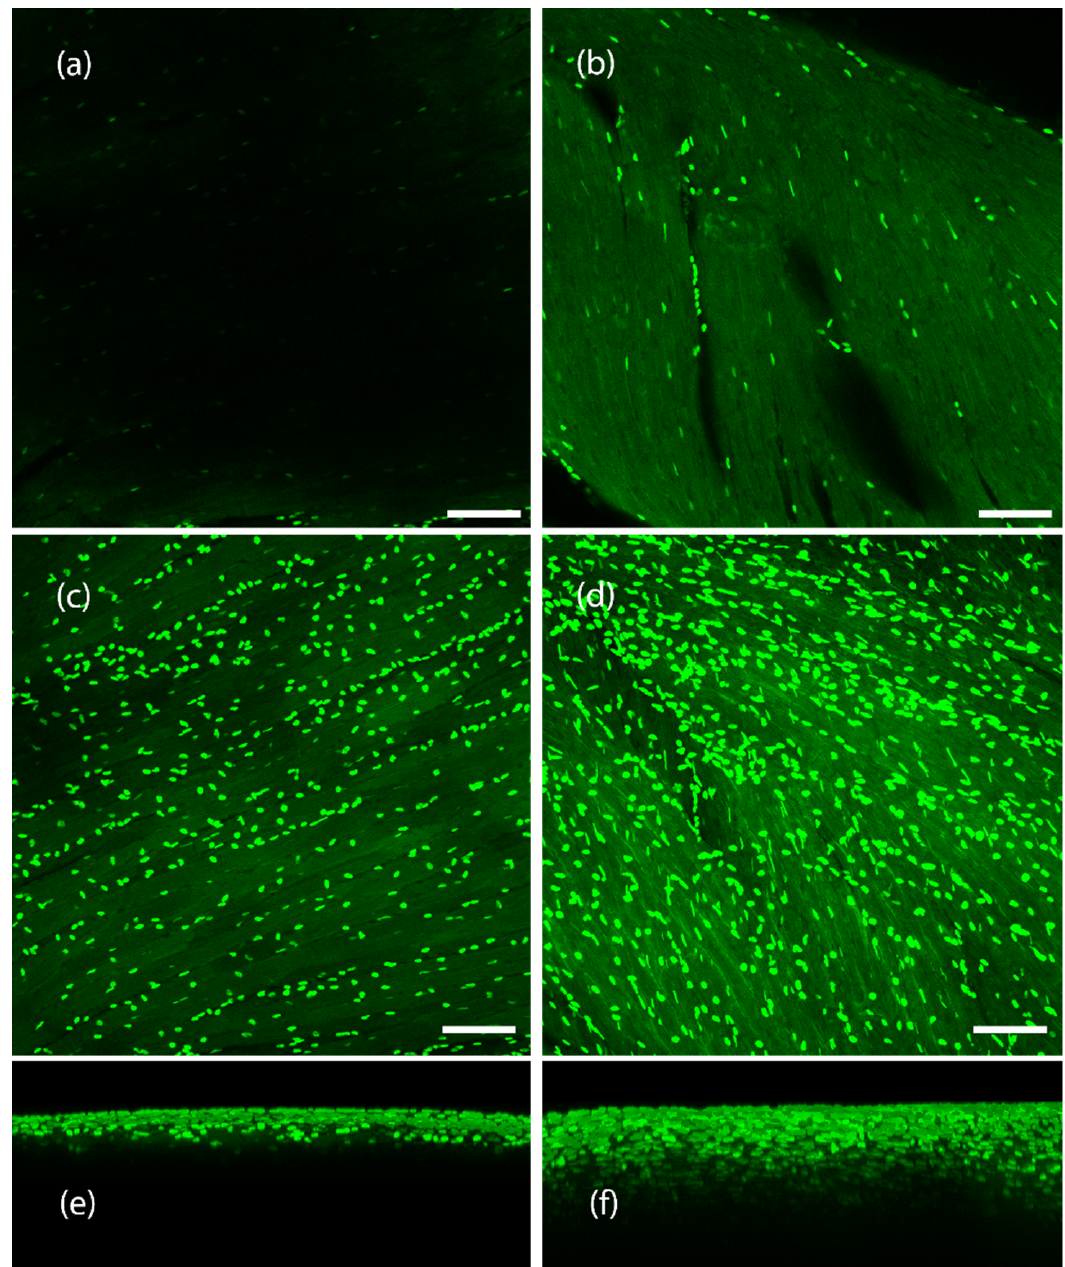
Figure 11. Clearing of a mouse heart tissue using HyClear. ( a , b ) Image slices of a mouse heart tissue with GFP-positive fibroblasts, using a 20 × lens, at 44 µ m, ( a ) before and ( b ) after tissue clearing. ( c , d ). MIP images of a mouse heart tissue using a 20 × lens, with GFP-positive fibroblasts, ( c ) before and ( d ) after tissue clearing. 3-D reconstructed z-stack image of mouse heart before tissue clearing. ( e , f ) 3-D reconstructed z-stack image of mouse heart ( e ) before and ( f ) after tissue clearing. The imageable depth of the tissue increases from about 50 µ m in image ( e ) (before) to about 155 µ m in image ( f ) (after). The scale bars represent 100 µ m.